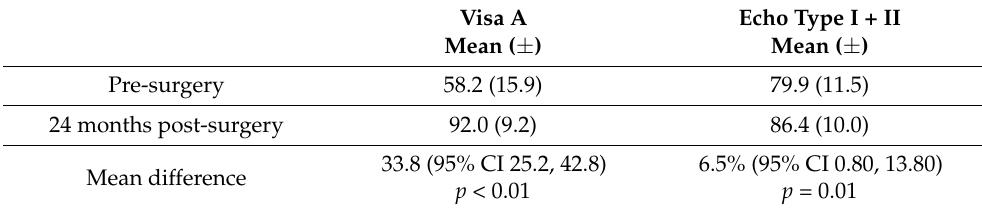
Table 2. Results of VISA-A and